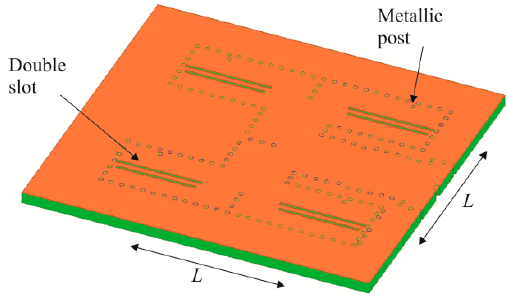
Figure 17. Basic 4 × 2 antenna block in SIW technology.